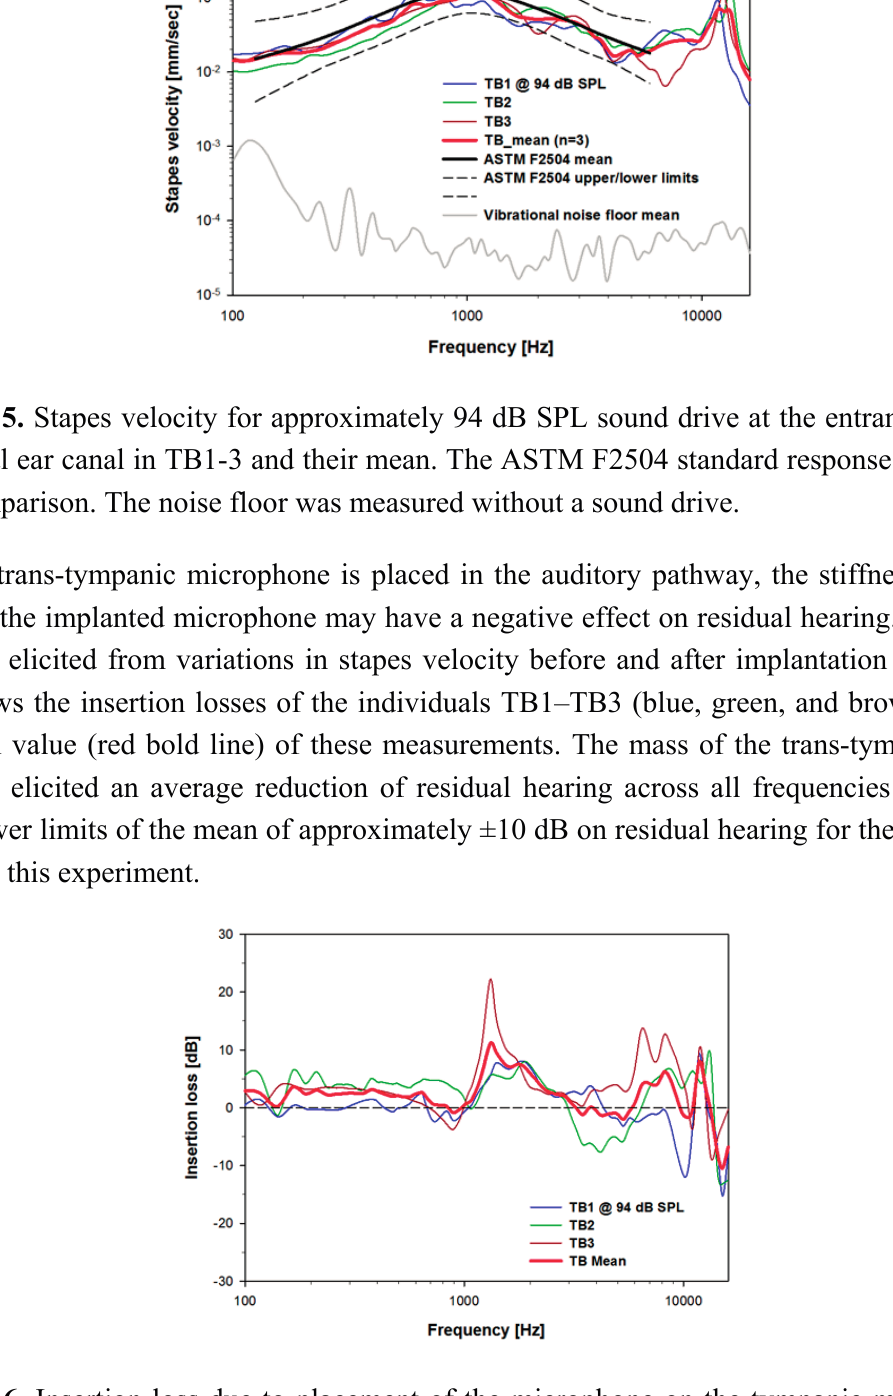
Figure 6. Insertion loss due to placement of the microphone on the tympanic membrane, which is the difference in dB between the stapes velocity before and after placement of the ventilation tube on the tympanic membrane, for TB1-3 and the mean